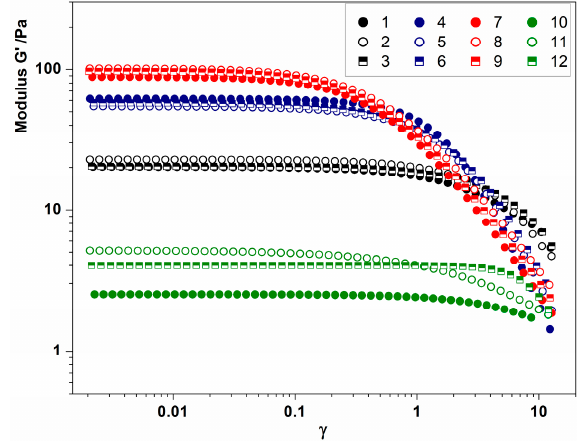
Figure 3. Amplitude strain sweep for hydrogels produced with low Ca 2+ content (black symbols), medium Ca 2+ content (blue symbols), high Ca 2+ content (red symbols) and low alginate, and medium* Ca 2+ content (green symbols). For detailed sample compositions, see Table 1.